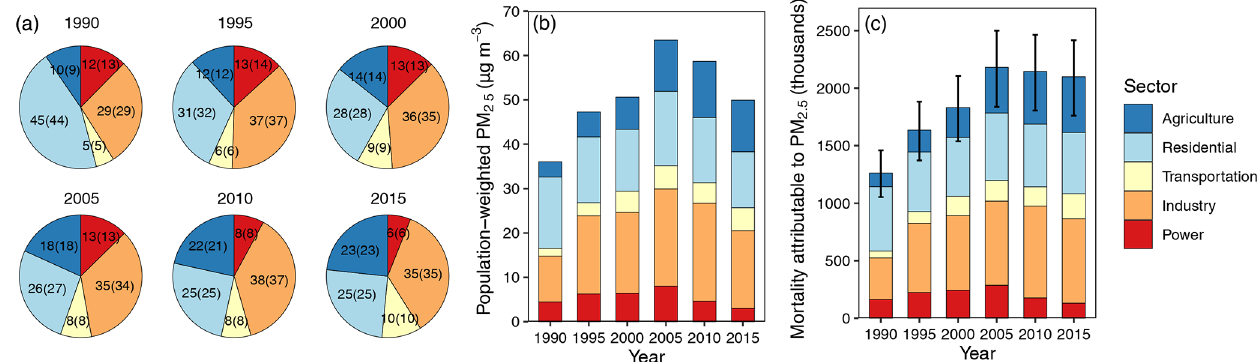
Figure 5. Relative and absolute source contributions to national population-weighted PM 2 . 5 concentrations and related premature mortal- ity estimated with GEMM NCD + LRI functions. (a) Relative source contributions (%) to national population-weighted PM 2 . 5 concentra- tions (numbers outside brackets) and related premature mortality (numbers inside brackets). (b) Absolute source contributions to national population-weighted PM 2 . 5 concentrations (µgm − 3 ). (c) Absolute source contributions to national PM 2 . 5 -related premature mortality (thou- sands) estimated with GEMM NCD + LRI functions.